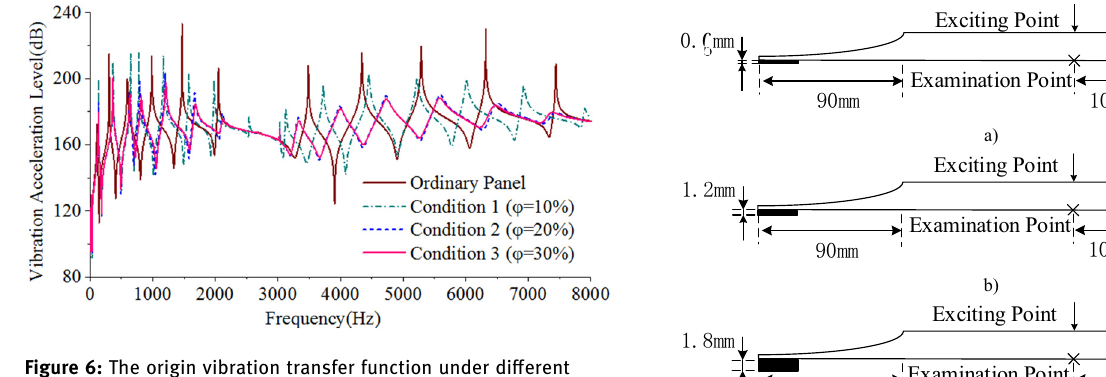
Figure 6: The origin vibration transfer function under di ff erent damping length ratios in the full frequency range.